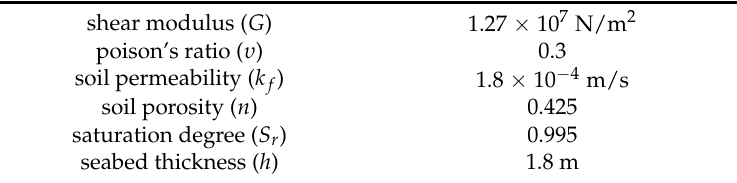
Figure 4. The vertical distributions of the maximum pore pressure ( p s / p 0 ) versus the seabed depth ( z / h ) . Table 1. The soil parameters for the present study.